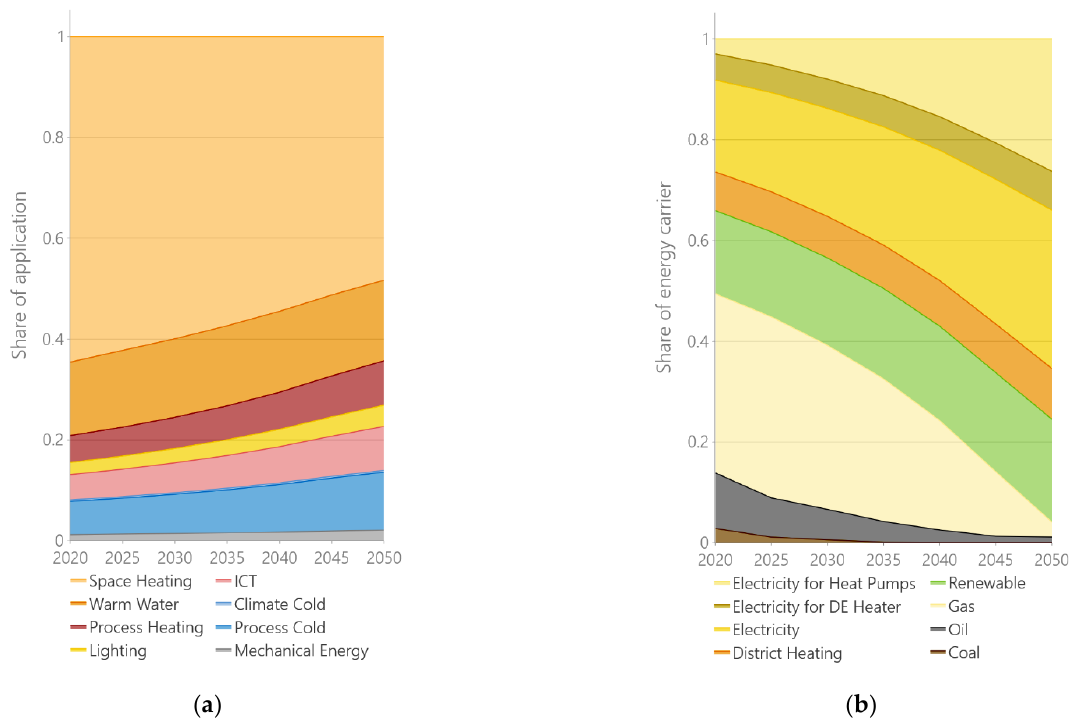
Figure 5. Shareofapplication( a )andshareofenergycarriers( b )intheFECintheprivatehousehold